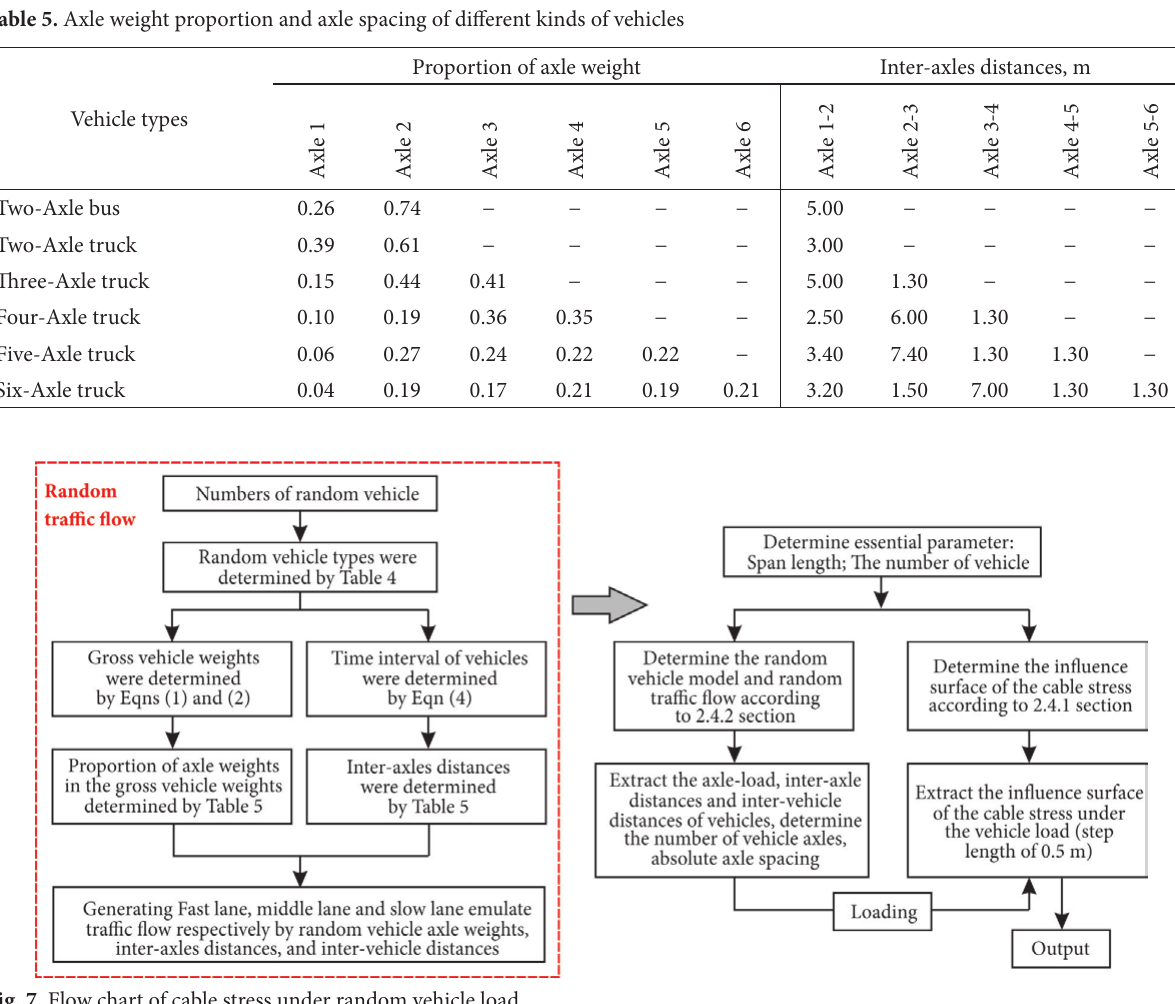
Fig. 7. Flow chart of cable stress under random vehicle